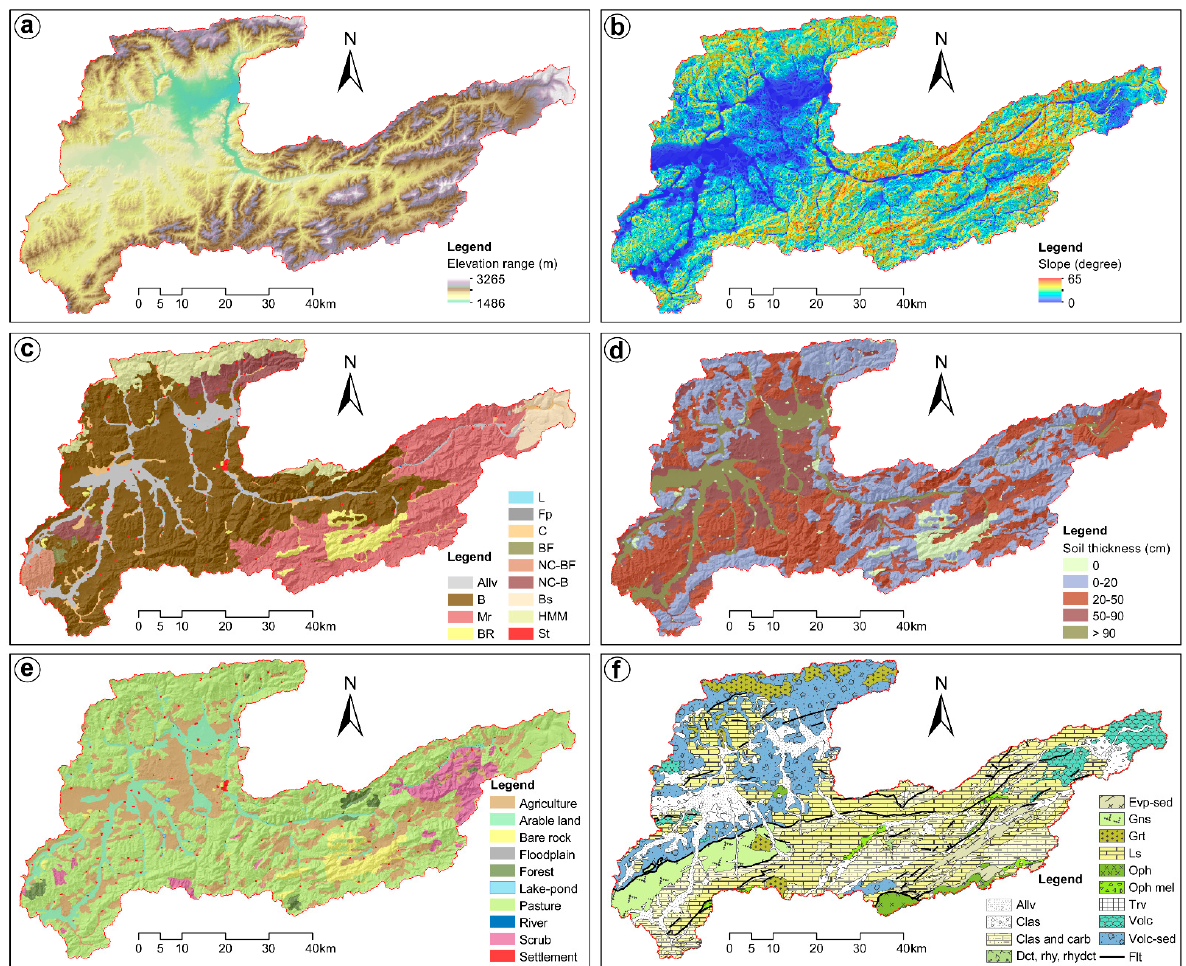
Figure 2. Maps showing: ( a ) digital elevation model (DEM); ( b ) slope map; ( c ) major soil classes (modified from [42]) (abbreviations: Allv = Alluvium, B = Brown soil, Mr = Maroon, BR = Bare rock, L = Lake-pond, Fp = Floodplain, C = Colluvium, BF = Brown forest soil, NC ‒ BF = Non-calcic brown forest soil, NC ‒ B = Non-calcic brown soil, Bs = Basaltic soil, HMM = High-level mountain meadow, St = Settlement); ( d ) soil thickness [42]; ( e ) major land-use classes [43]; ( f ) subsurface lithology (abbreviations: Allv = Alluvium, Clas = Clastic rock, Clas and carb = clastic and carbonate rock, Dct,rhy, rhydct = Dacite ‒ rhyolite ‒ rhyodacite, Evp ‒ sed = Evaporite and sedimentary rock, Gns = Gneiss, Grt = Granitoid, Ls = Limestone, Oph = Ophiolite, Oph mel = Ophiolitic mélange, Trv = Travertine, Volc = Volcanite, Volc ‒ sed = Volcano sedimentary rock, Flt = Fault) (modified from [44,45]).